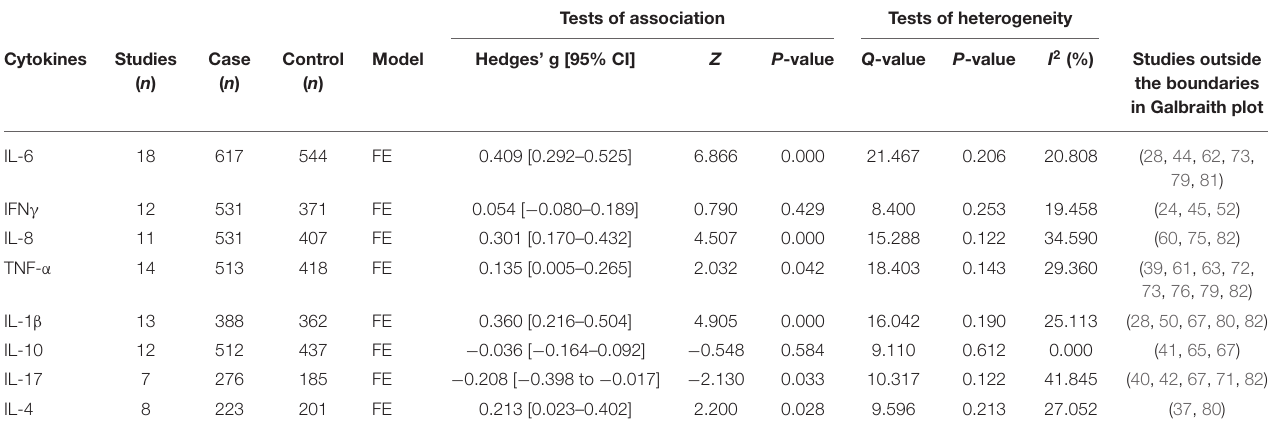
TABLE 2 | Summary of meta-analysis results after removing studies outside the boundaries in Galbraith